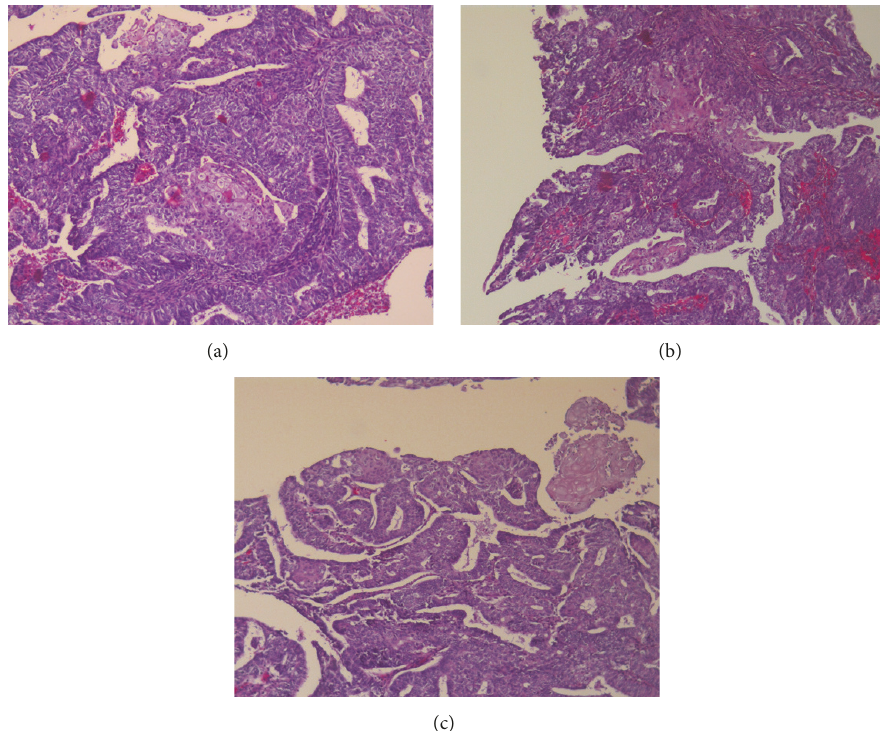
Figure 2: Microscopic appearance of endometrioid carcinoma with foci of squamous differentiation.